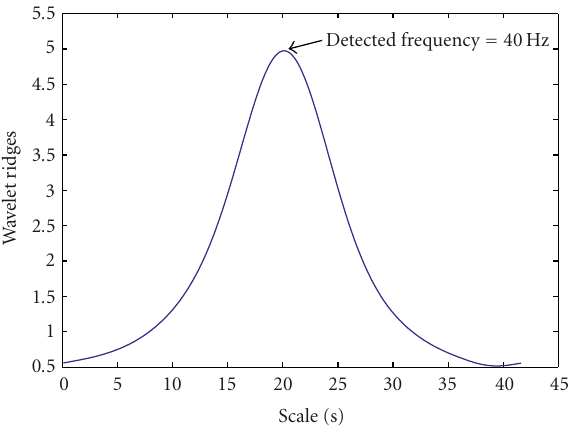
Figure 4: Denoised wavelet ridges plot of the wavelet ridges plot in Figure 3.